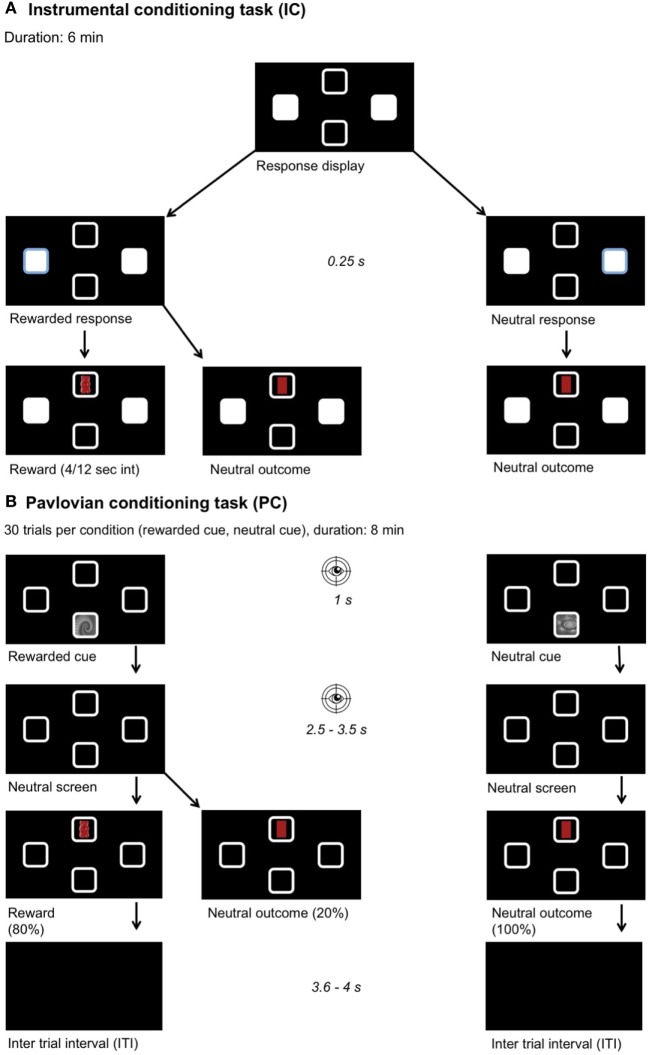
Experimental setup. Participants chose their preferred food out of four options (chocolate, gummy bears, crackers, crisps). A picture of this food was then used as a reward during learning. Participants were instructed they would receive a proportional amount of the collected foods after the experiment. The position of the outcome and stimulus and all learning associations were pseudo-randomized across participants. (A) Instrumental conditioning: participants learned the response–outcome associations, one key press yields a reward and the other a neutral outcome. A partial reinforcement schedule was used with a variable time interval between 4 and 12 s. (B) Pavlovian conditioning: participants learned the stimulus–outcome associations, one fractal yields a reward and the other a neutral outcome. After stimulus presentation, a neutral screen showing four empty squares appeared. Eye movements were recorded during stimulus and neutral screen presentation to measure the conditioned response toward the rewarded cue. (C) Pavlovian-to-instrumental transfer task: we measured the influence of the previously learned associations on the response behavior when the same stimuli as before were presented and under nominal extinction.